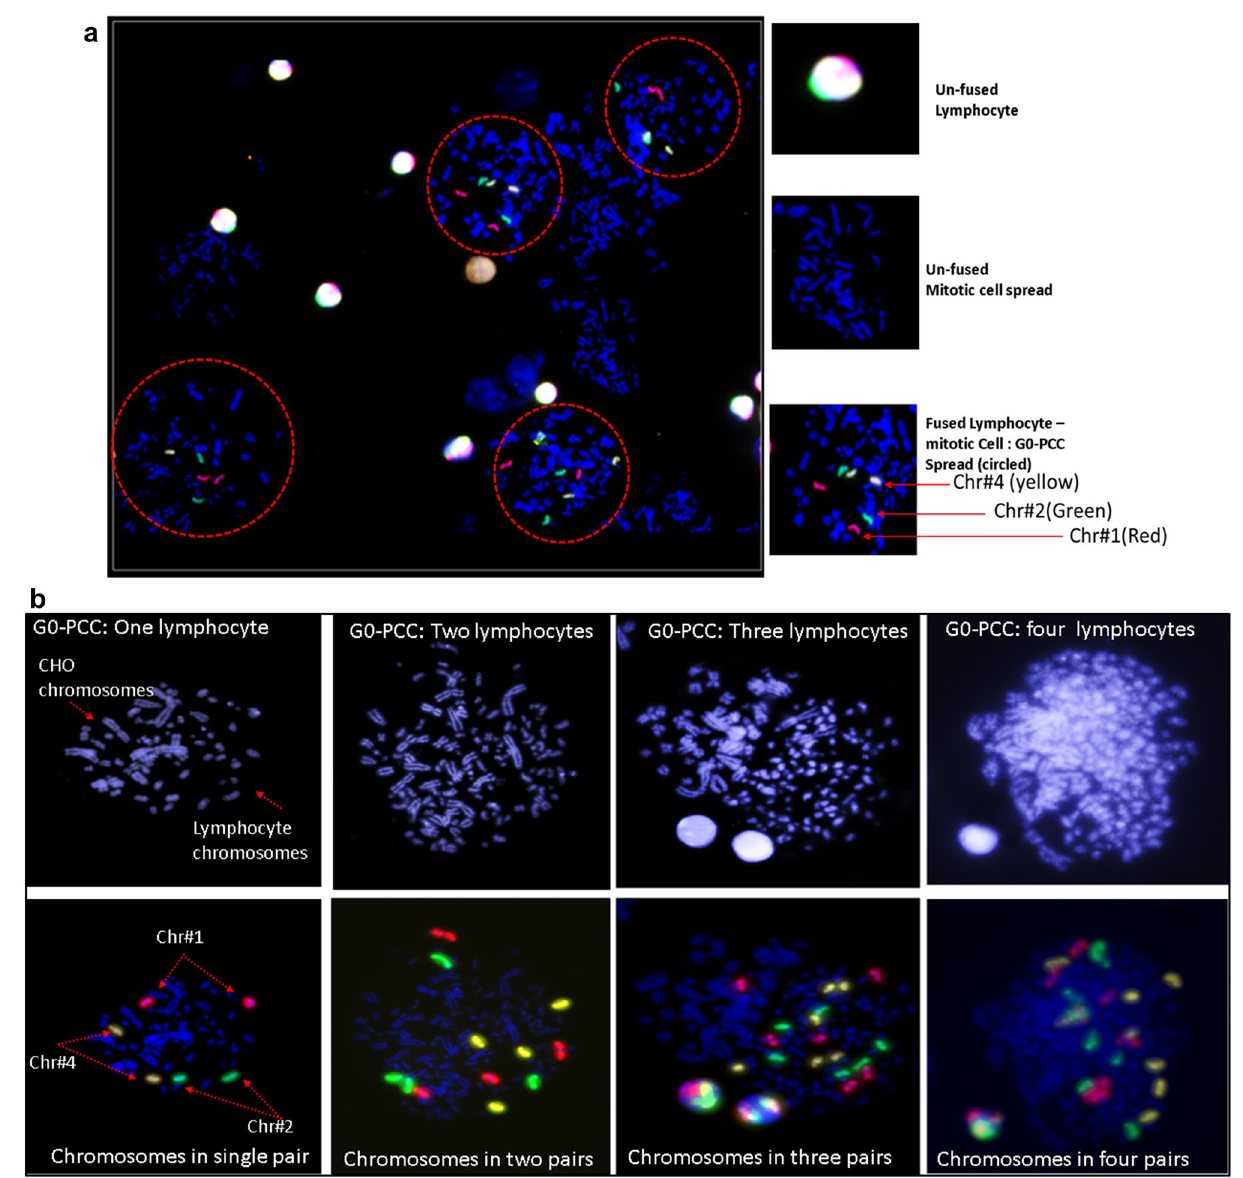
Figure 4. ( a ) A typical field of chromosome spread preparation G 0 -PCC FISH slide showing efficient fusion yield. PCC spread can be identified by the presence of painted human chromosome pairs 1, 2 and 4 in red green and yellow respectively (encircled), ( b ) G 0 -PCC spreads from one, two, three or four lymphocyte fusion to mitotic cell/s. Increase in number of lymphocyte chromosomes and size of the spread can be observed (top row, left to right). Multichannel view of spread shows red green and yellow fluorescent signals from painted chromosomes 1, 2 and 4, respectively. Since one lymphocyte caries one pair of each chromosome, presence of one, two, three and four pairs of each of the painted chromosomes confirm fusion of one two three and four lymphocyte respectively (left to right bottom